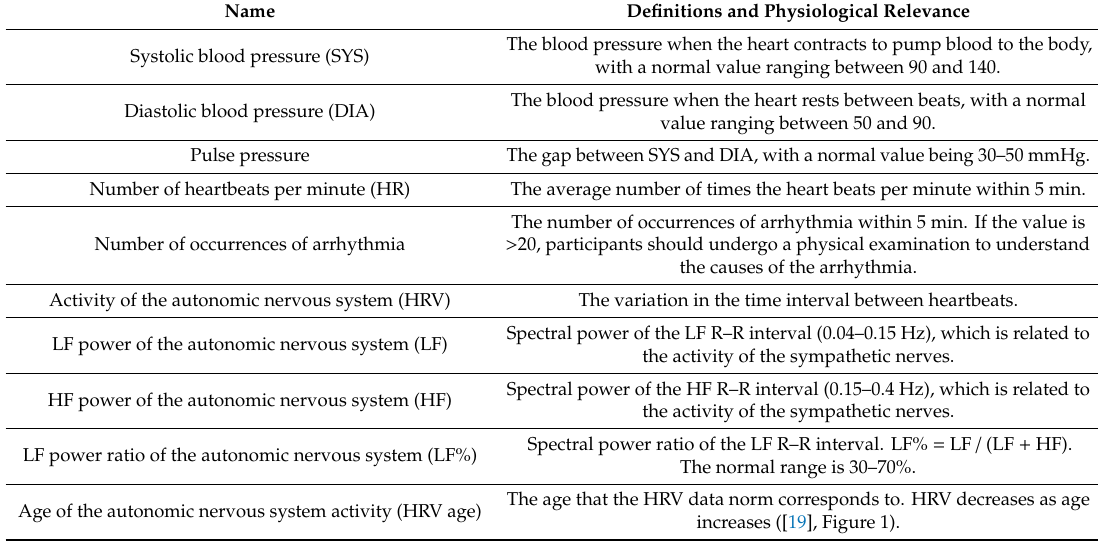
Table 3. Definitions of the physiological parameters and their physiological